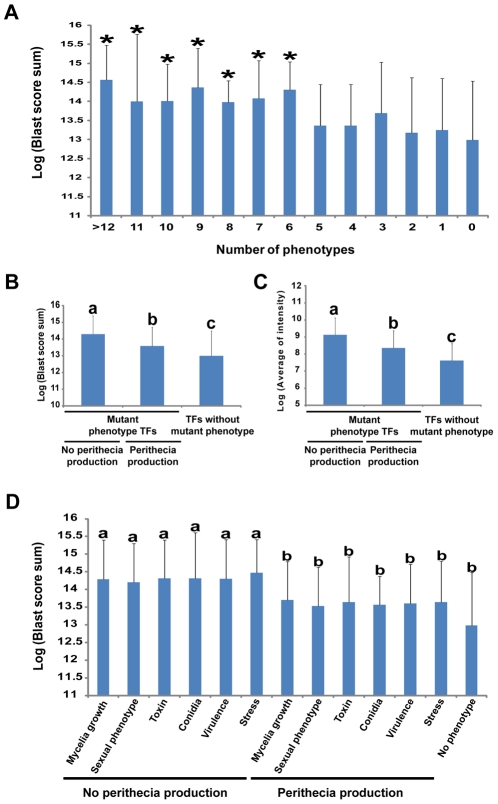
Relationship between multiple phenotypes, gene conservation in fungal kingdom, and transcription factor (TF) expression levels.(A) Relationship between BLAST score sum and number of phenotype changes caused by a single TF deletion. Statistical analysis was performed using the Fisher LSD test. *p<0.05. (B) Correlation between TF conservation and various phenotypes with and without perithecia formation. (C) Comparison of expression level and mutant phenotype TFs with and without perithecia formation. Statistical analysis for (B) and (C) was performed using the Duncan multiple range test. Values with different superscript letters are significantly different (p<0.01). (D) Relationship between BLAST score sum and the no perithecia formation phenotype. Statistical analysis was performed using the Duncan multiple range test. Values with different superscript letters are significantly different (p<0.05).